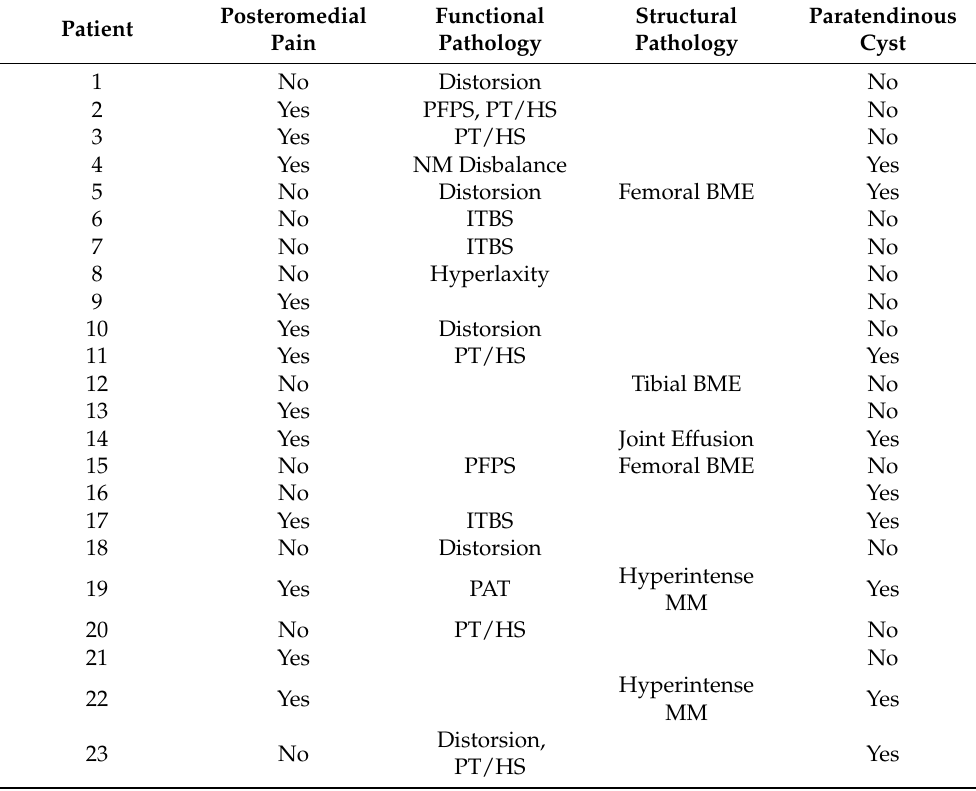
Table 1. Presentation and accompanying functional and/or structural pathologies as well as preva- lence of paratendinous cystic lesions according to clinical examination and MRI for every single patient ( n =